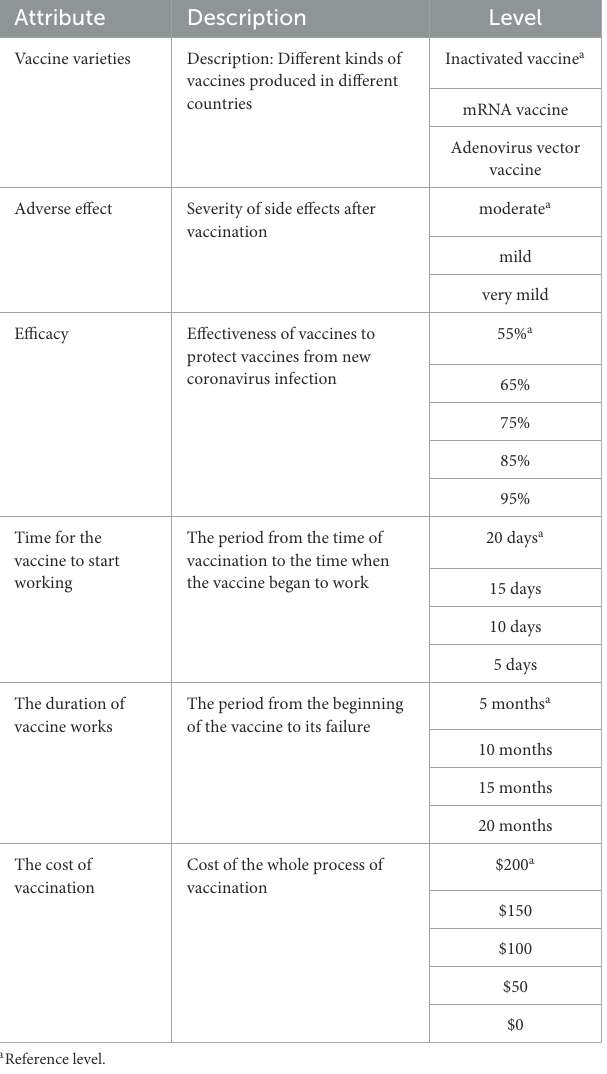
TABLE 2 An example of choice-based conjoint in the questionnaire.